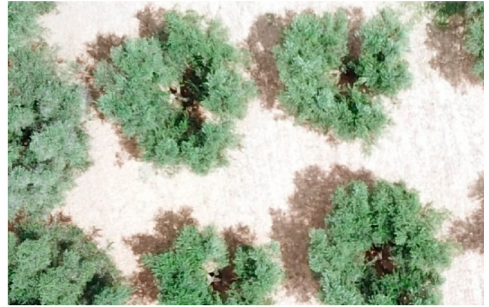
Figure 3. High resolution frame portion acquired by Unmanned Aerial Vehicle (UAV) at Oria field on September